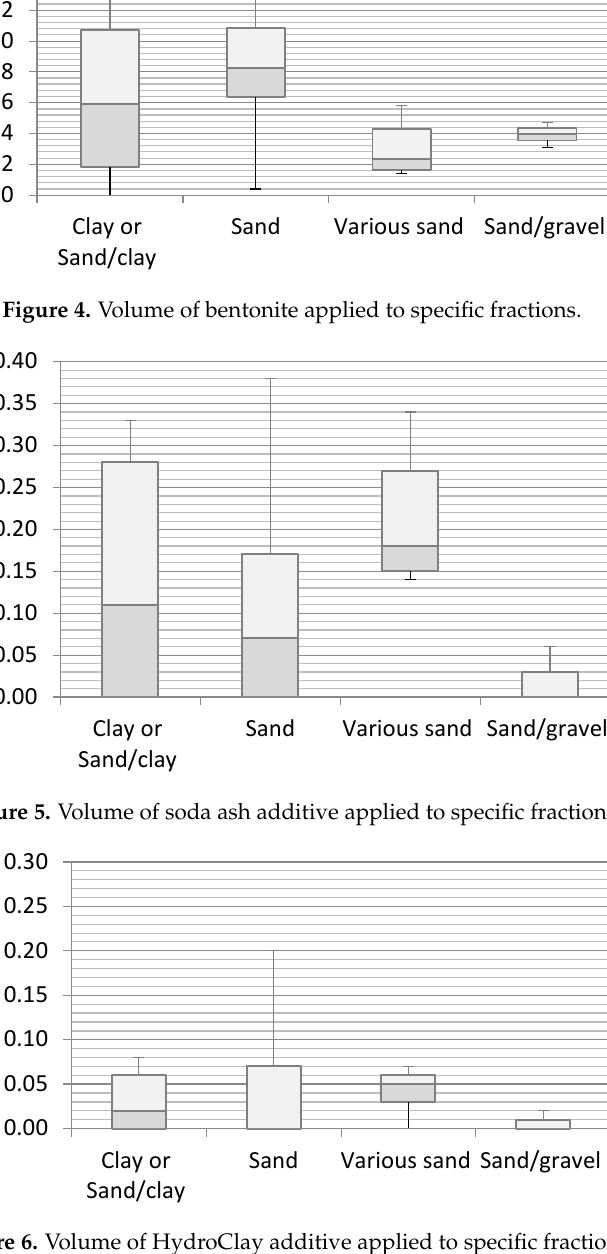
Figure 6. Volume of HydroClay additive applied to specific fractions.